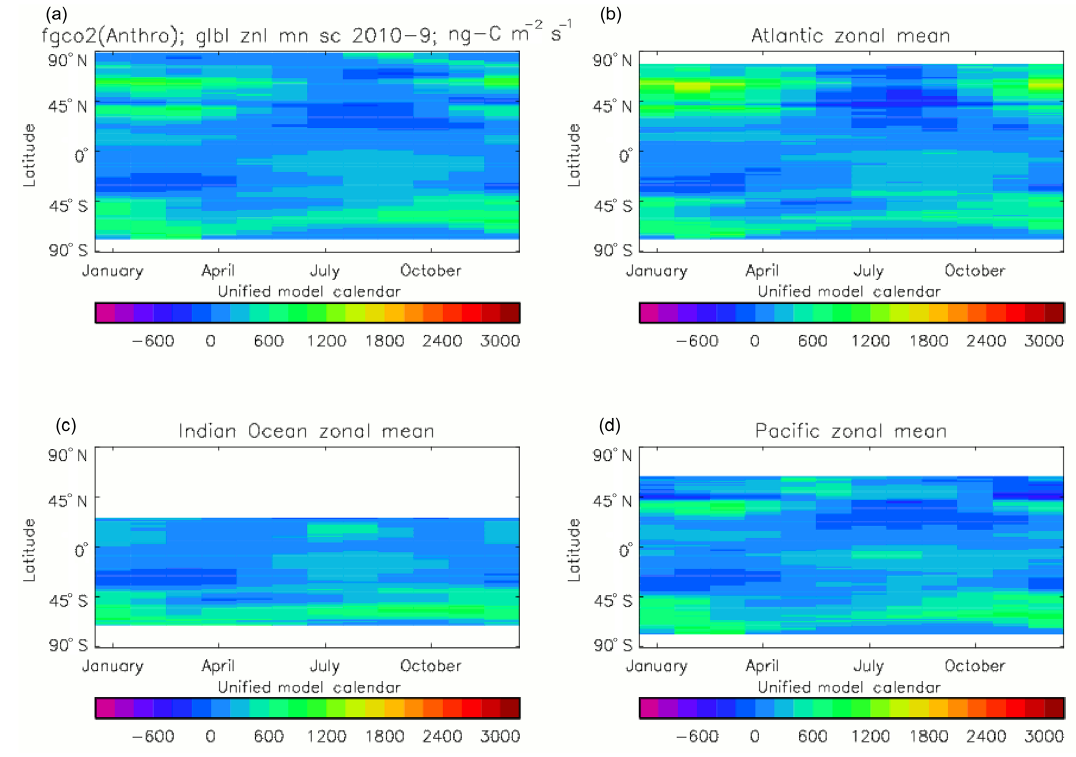
Figure 21. As Fig. 20, but for the air-to-sea flux of anthropogenic CO 2 only (ngCm − 2 s − 1 ).